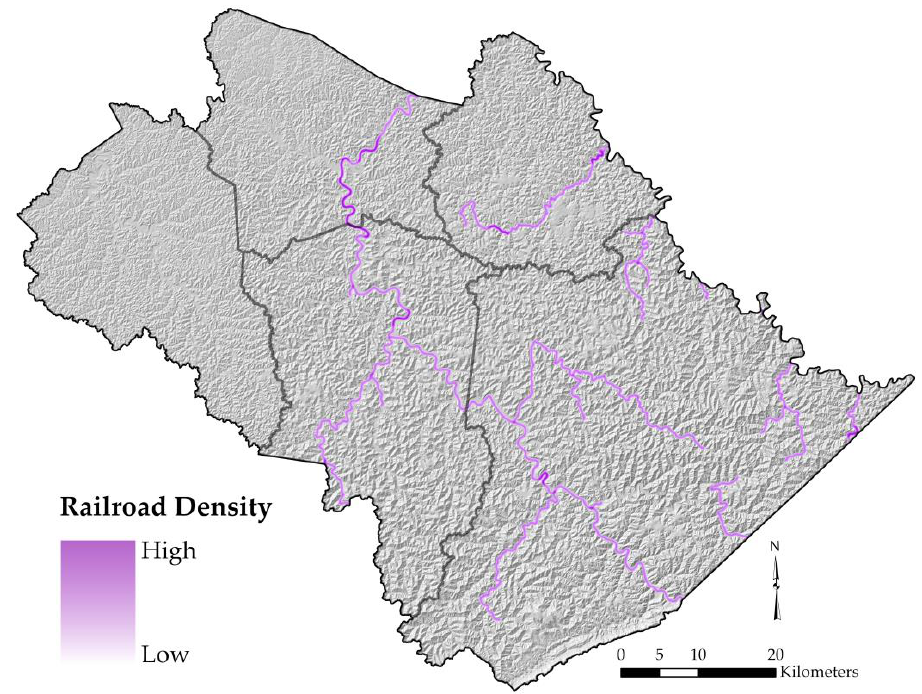
Figure 8. Kernel density map of railroads for the Big Sandy Area Development District. The low to high range of density classification represents the units of length of line per one square map